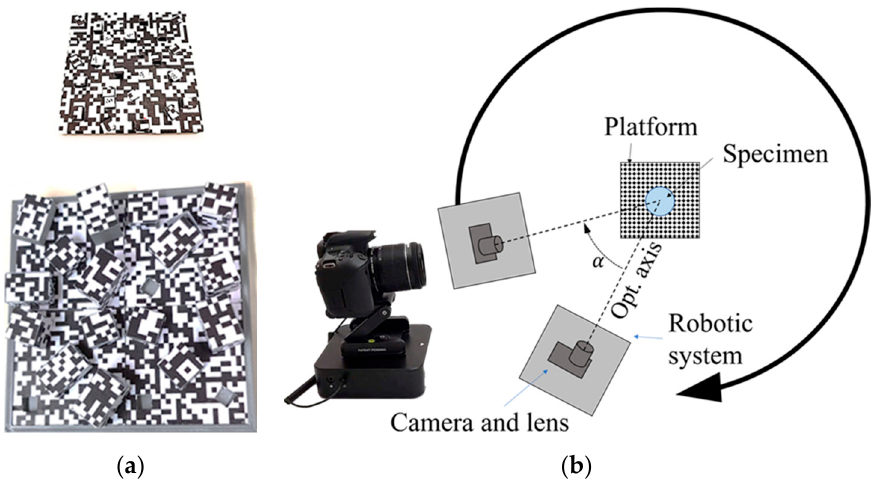
Figure 3. Photogrammetric equipment and data acquisition protocol: ( a ) calibration pattern for macro lens (up) and for zoom lens (down); ( b ) robotic device linked with the DSLR camera and automatic movement of the platform through the configured path (without operator).